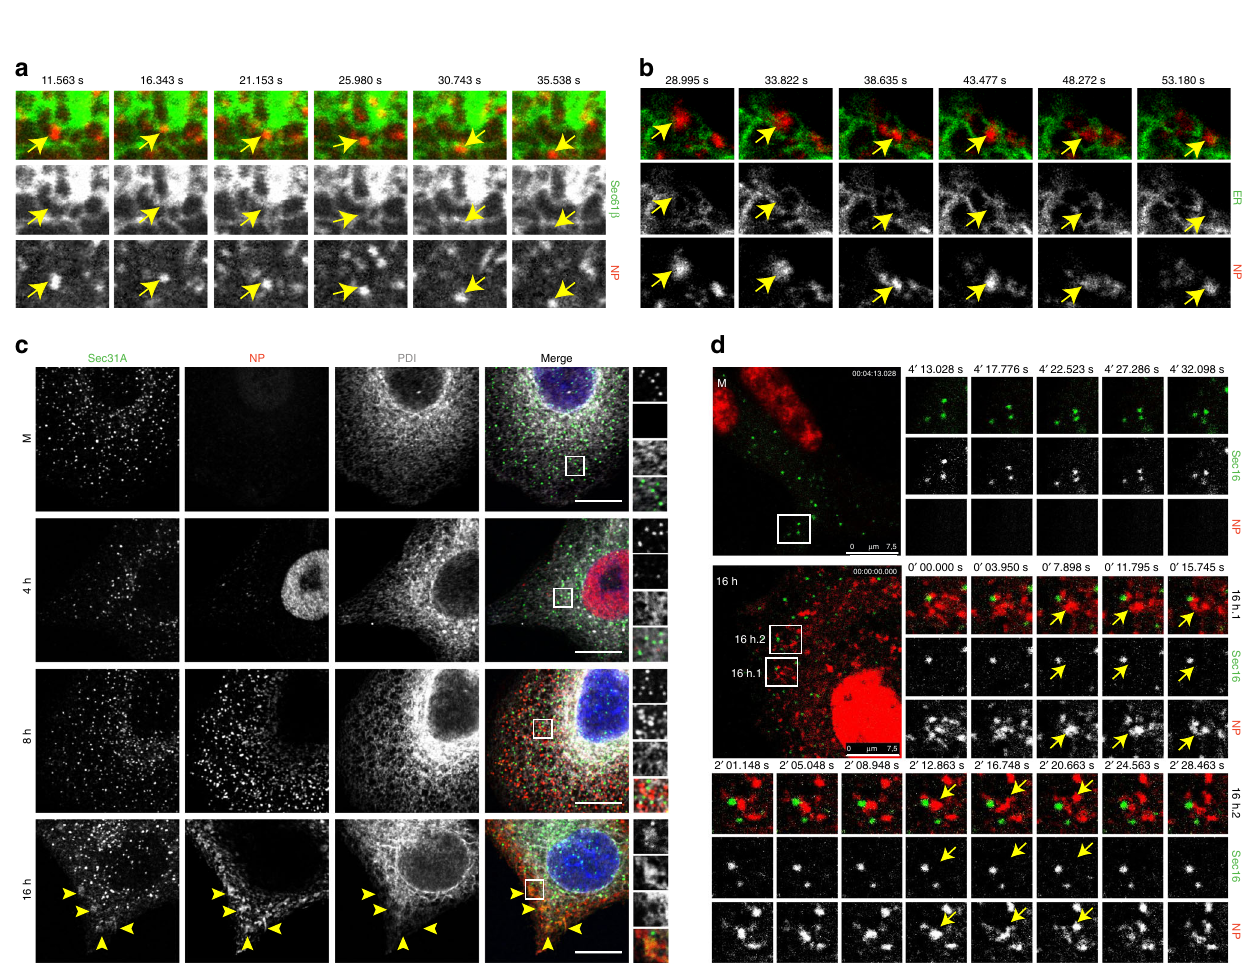
Fig. 5 Viral inclusions are associated with ER exit sites. a Sec61 β -Emerald cells were transfected with mCherry-NP and infected with PR8 virus, at an MOI of 10, for 16 h. b A549 cells were co-transfected with plasmids encoding mCherry-NP and ER-GFP and infected with PR8 virus, at an MOI of 10, for 16 h. a , b Cells were imaged under time-lapse conditions. Individual frames with single moving particles highlighted with yellow arrows are shown. Images were extracted from Supplementary Movies 17 and 18. More than 15 cells from 3 independent experiments were analyzed in each condition. c A549 cells were infected or mock-infected (M) with PR8 virus, at an MOI of 3, and fi xed at the indicated times. Cells were stained for the ER proteins Sec31A (in green) and PDI (in gray) and the viral NP protein (in red). Areas highlighted by the white box are shown on the right of each panel. Yellow arrowheads indicate co- localization between Sec31A and NP. Bar = 10 μ m. More than 30 cells from 2 independent experiments were analyzed. d A549 cells were co-transfected with plasmids encoding mCherry-NP and GFP-Sec16 and infected or mock-infected (M) with PR8 virus for 16 h. Cells were imaged under time-lapse conditions. Representative cells are shown in the left large images. Individual frames with single moving particles highlighted with yellow arrows are shown in the small panels. Two examples are provided for the infected cell (16 h.1 and 16 h.2). Bar = 7.5 μ m. Images were extracted from Supplementary Movies 19 and 20. Images are representative of at least 15 cells, from 2 independent